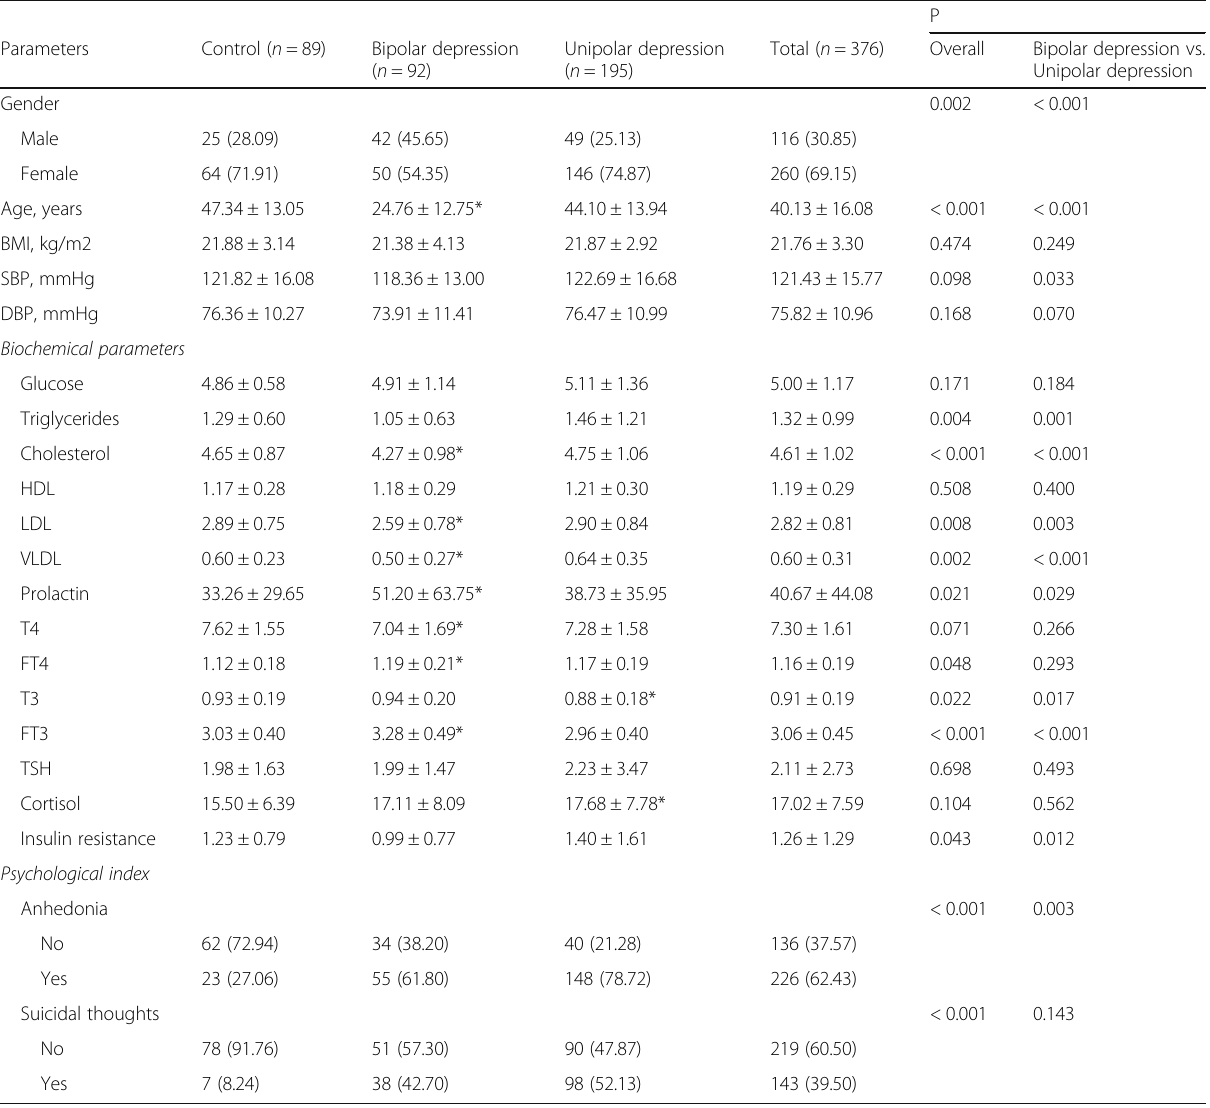
Table 1 Patient ’ s demographic and clinical characteristics